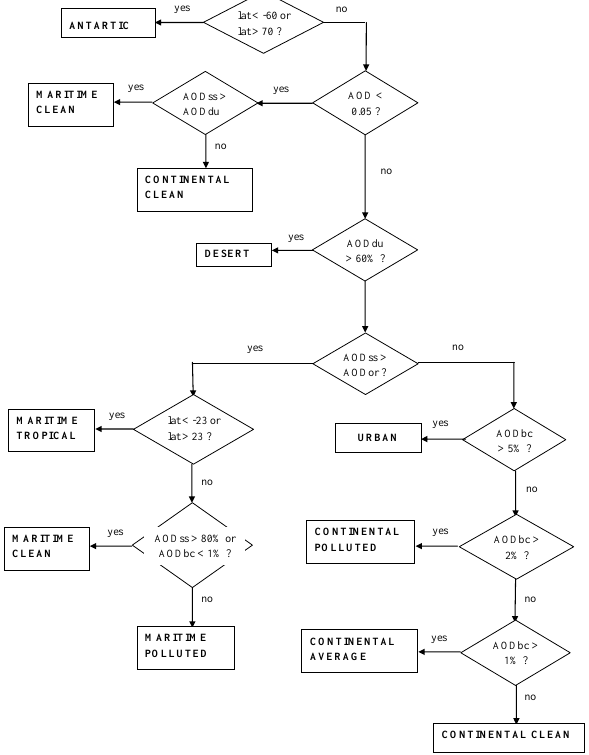
Fig. 1. Sketch of the algorithm converting the total optical depth 3 (AOD) and partial optical depths of MACC species – dust (AODdu), sea salt (AODss), black carbon (AODbc), and organic matter (AODor) – into aerosol types: urban, continental clean, continen- tal polluted, continental average, maritime clean, maritime polluted, maritime tropical, Antarctic, and desert. “lat” is latitude.